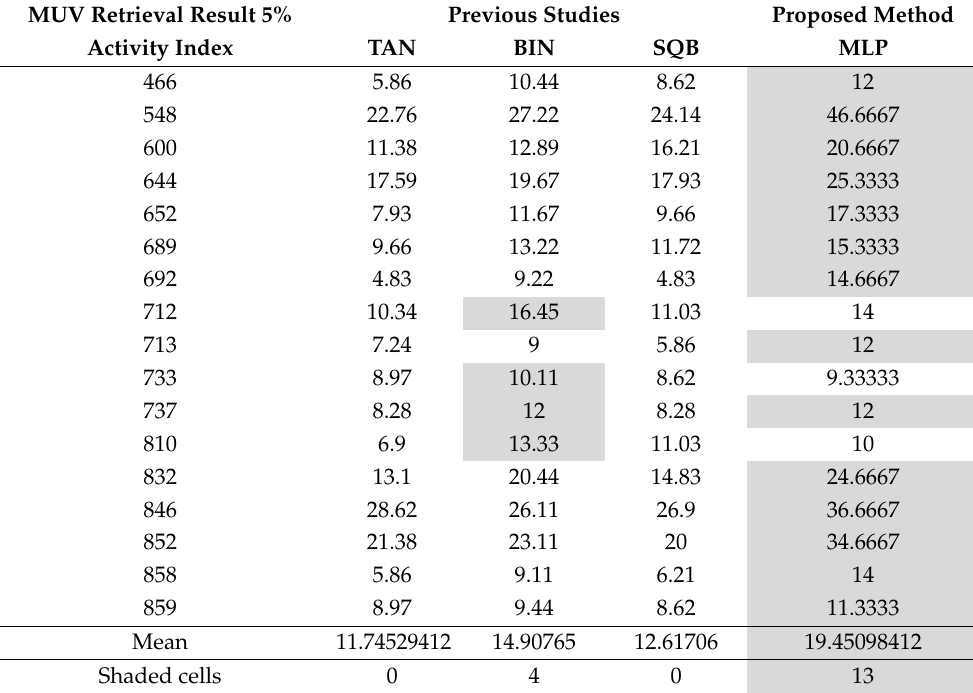
Table 13. Top 5% retrieval results for MUV dataset for descriptor (ECFC